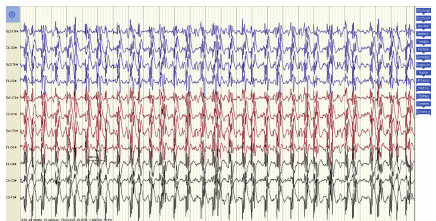
Figure 1: EEG pattern 36 hours after the patient suffered a cardiac arrest and treated with mild therapeutic hypothermia. After the sedative discontinuation, the EEG appeared unreactive with diffuse epileptiformdischarges(polyspike-wavecomplexes)associatedwith continuous spontaneous generalized multifocal jerks, involving the face, limbs, and axial